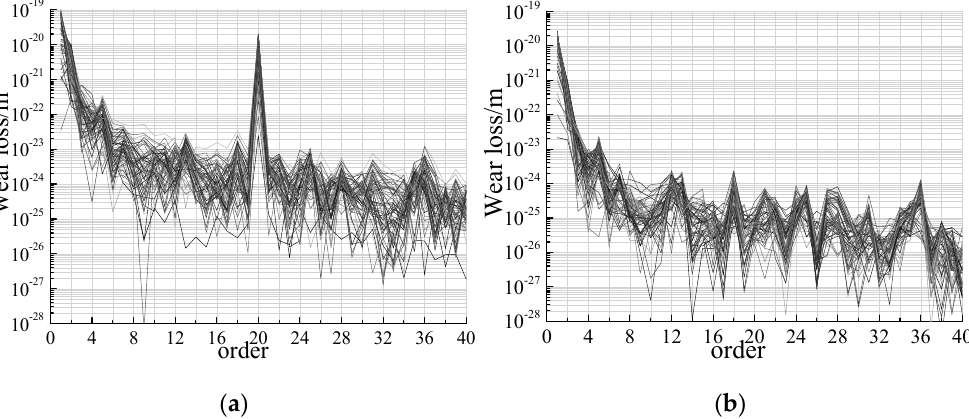
Figure 14. Spectra corresponding to Figure 13a,b. ( a ) Flexible wheelset and ( b ) Rigid wheelset.